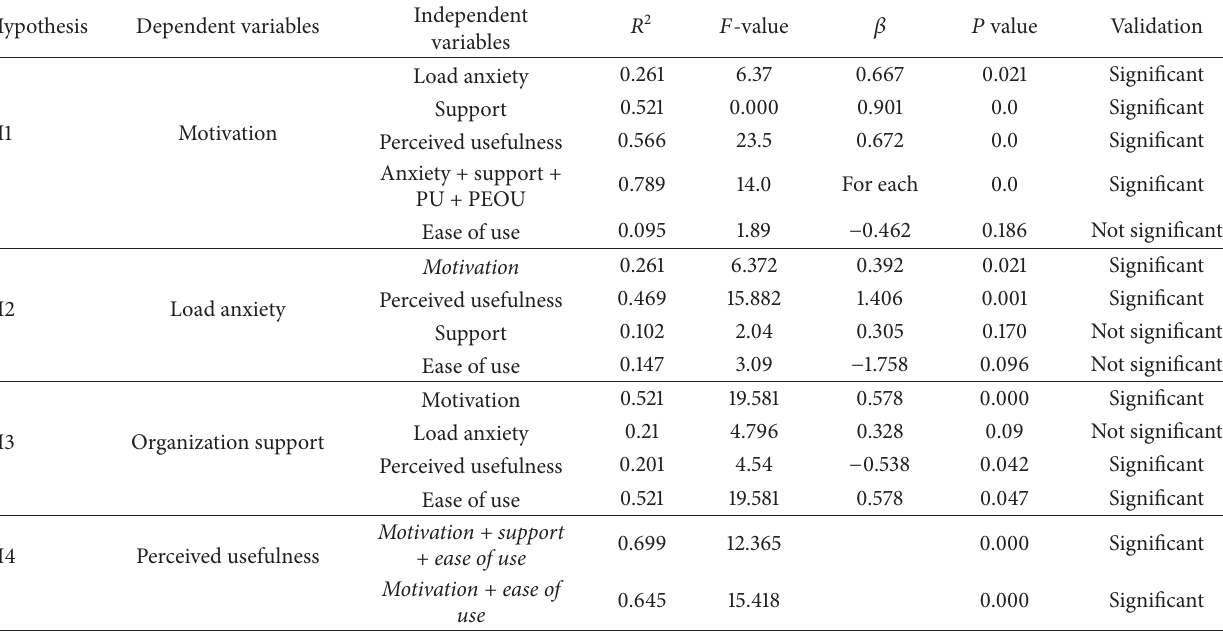
Table 4: Direct effect between independent constructs.